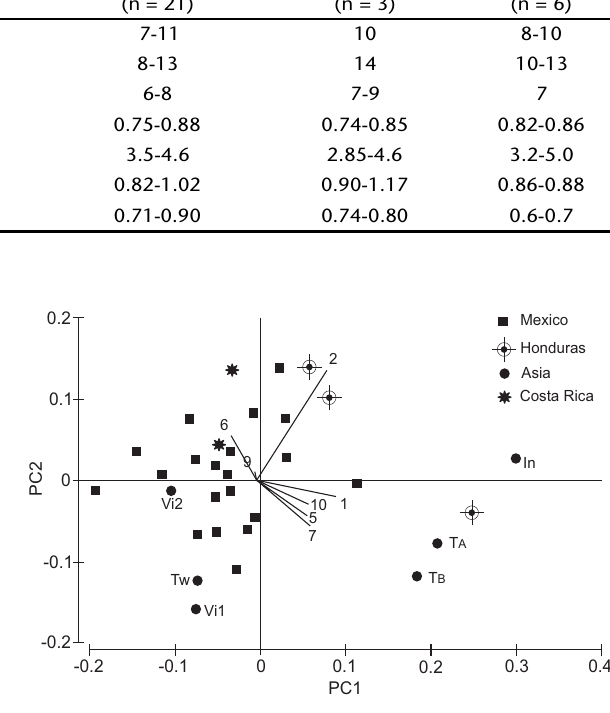
Figure 17. Principal Component Analysis (PCA) of meristic and morphometric data of specimens from different populations of M.